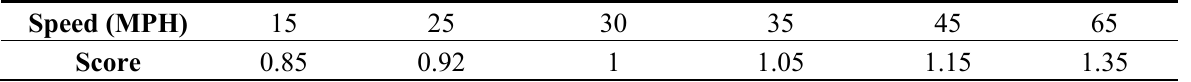
Table 1. Speed limit walkability